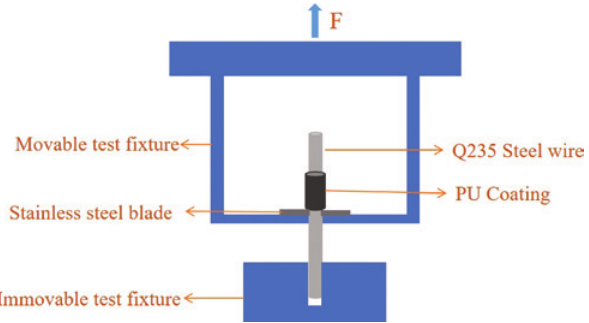
Figure 1: Bonding strength test configuration